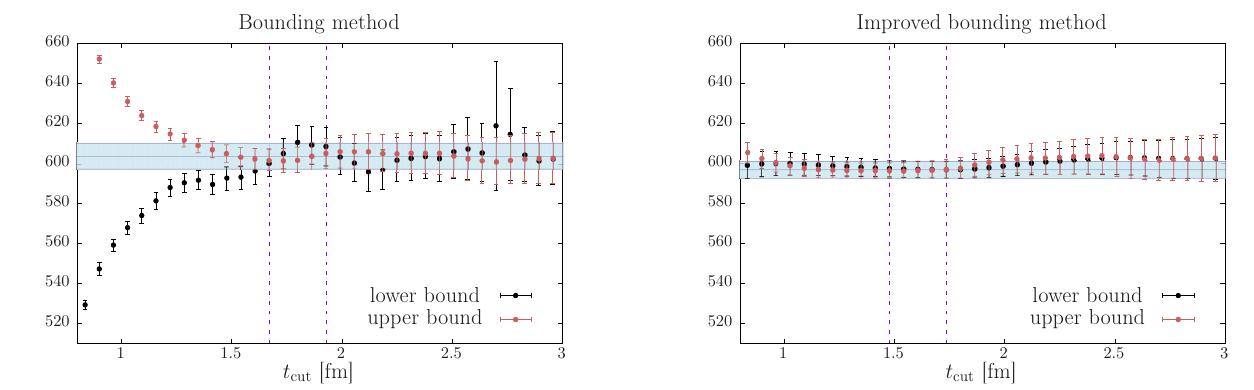
Figure 2. Upper and lower bounds for the (connected) light quark contribution to a hvp µ as a function of t 200 MeV. The right panel shows the bounds for the improved bounding method. Vertical lines indicate the interval over which the data are averaged, yielding the horizontal band which is identified with the actual estimate.